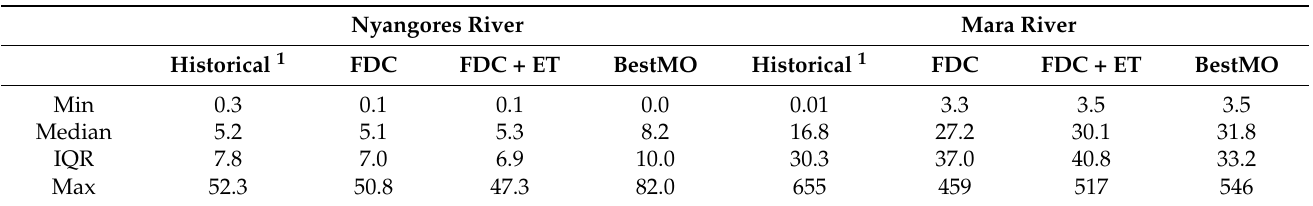
Table 4. Summary statistics for the simulated and observed mean annual streamflow duration curves (in m 3 /s) for